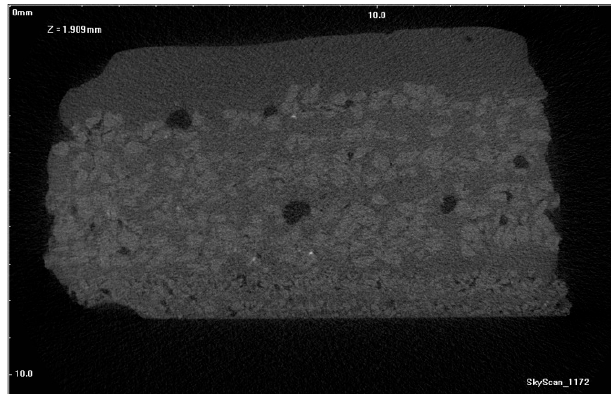
Figure 18. Example tomogram of PW2 sample cross section. Crystals 2020 , 10 , x